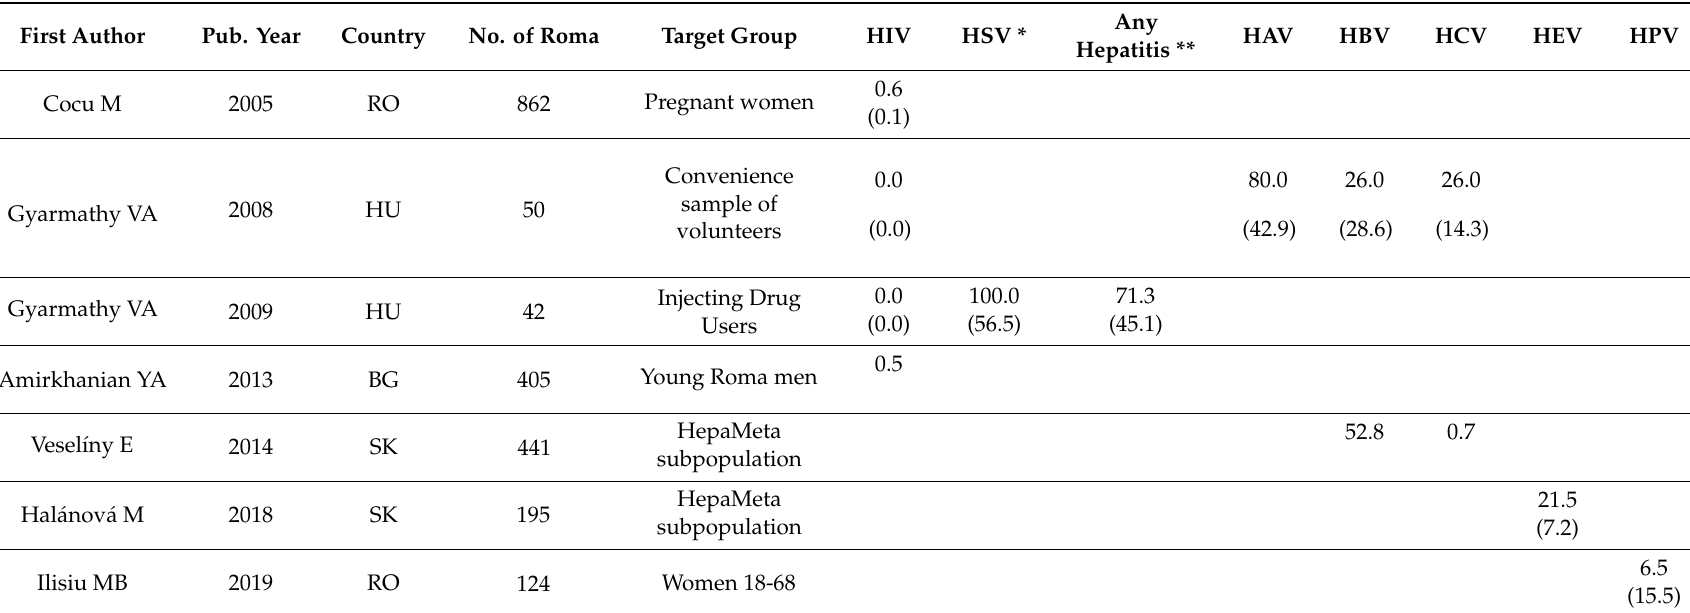
Table 2. Viral disease (per